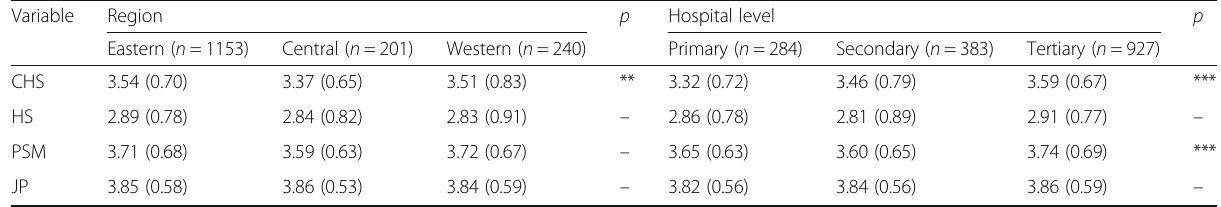
Table 3 The differences in challenge stress (CHS), hindrance stress (HS), public service motivation (PSM), and job performance (JP) between different regions and hospital levels Variable Region